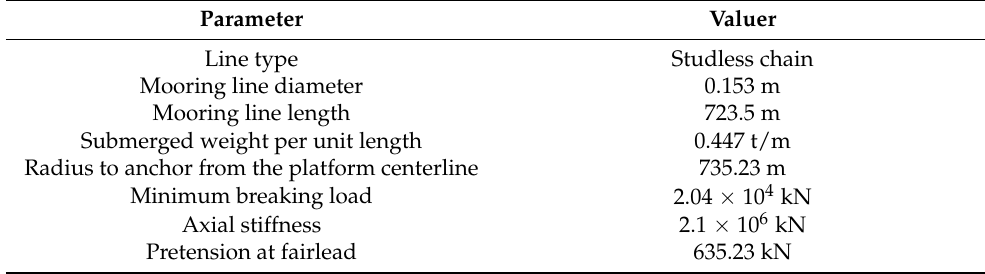
Table 5. Properties of the mooring